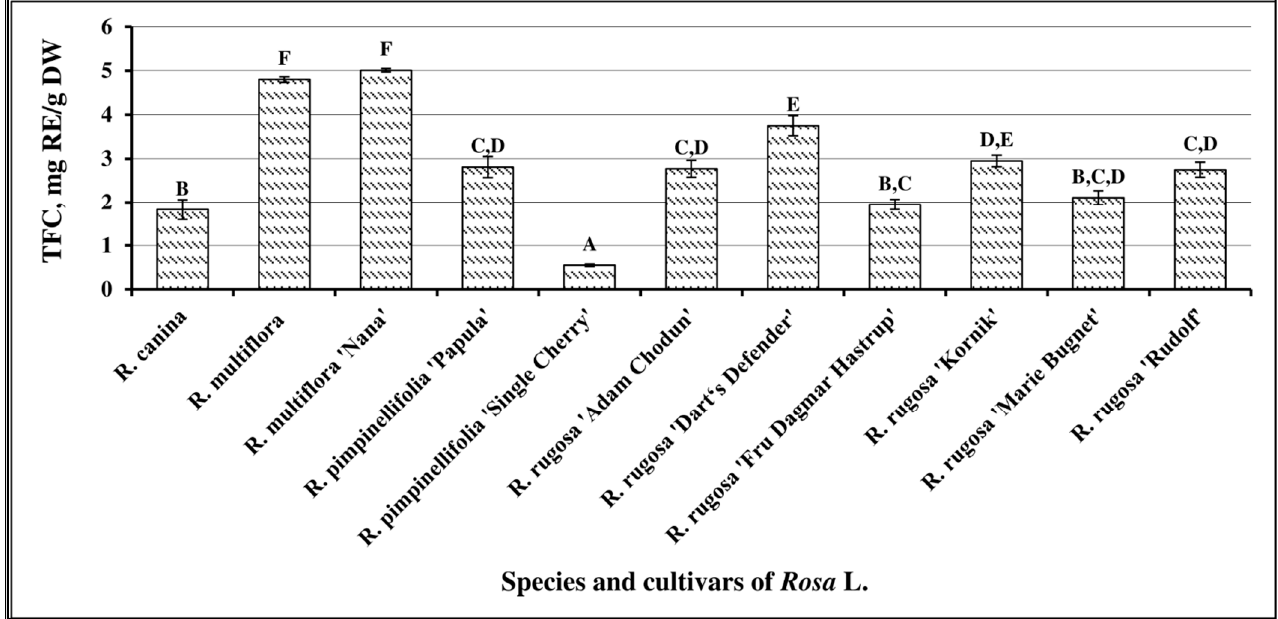
Figure 3. Variability of the total content of flavonoids in Rosa L. fruit samples; different letters indicate statistically significant ( p < 0.05) differences between the